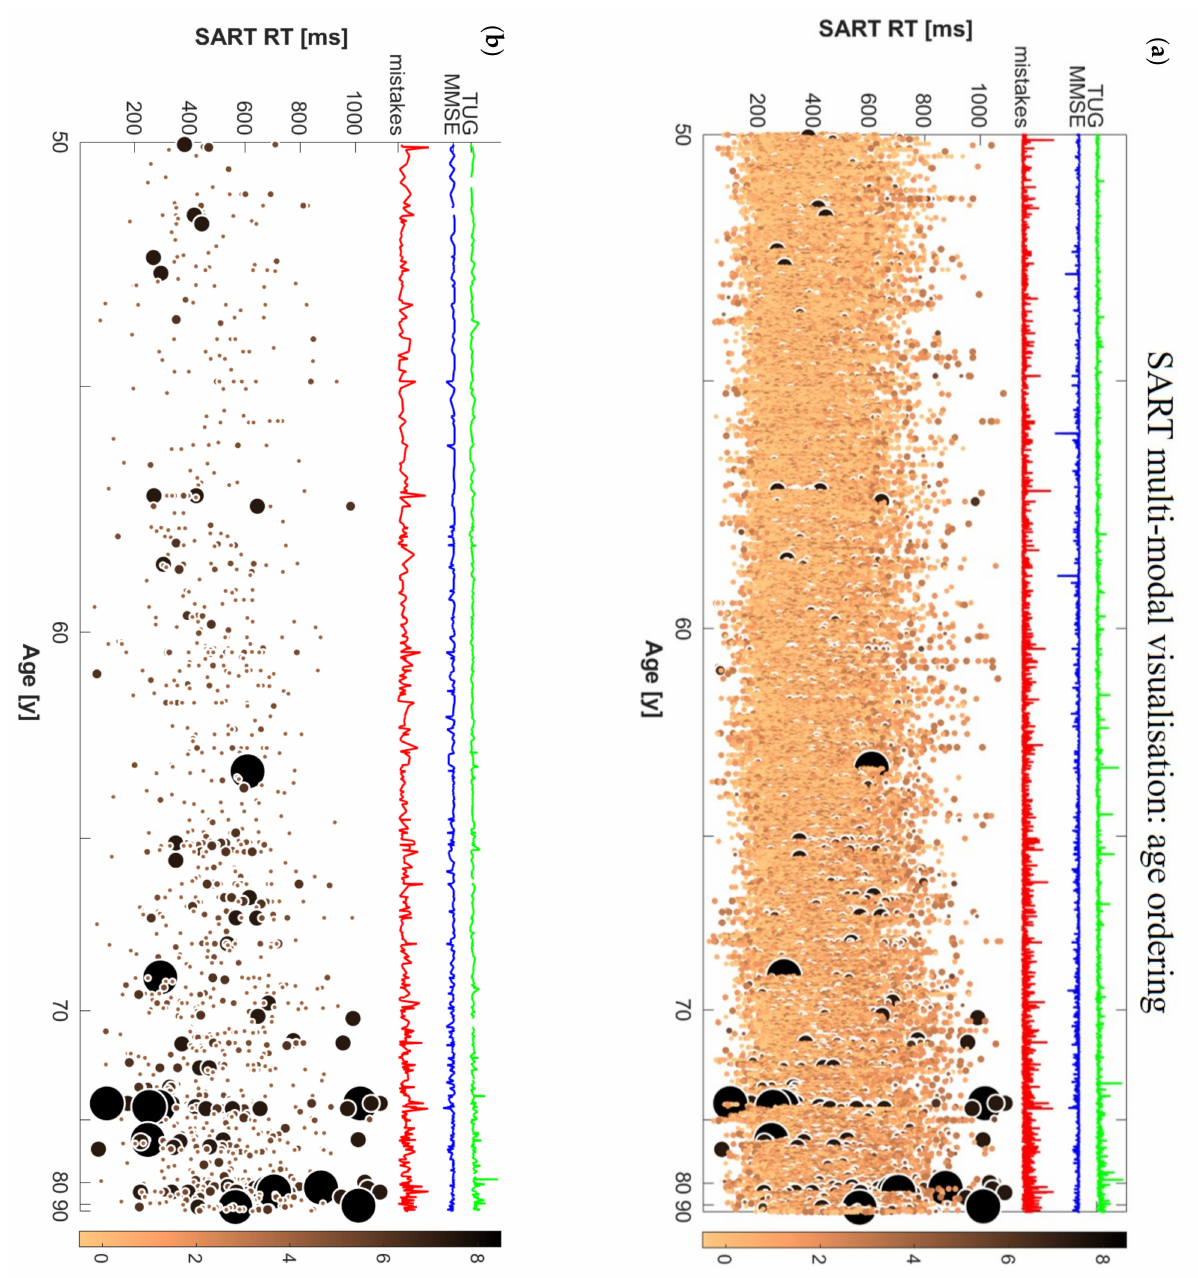
Figure 1. Multimodal visualisation of SART data, ( a ) ordered by age and ( b ) ordered by age with thresholding